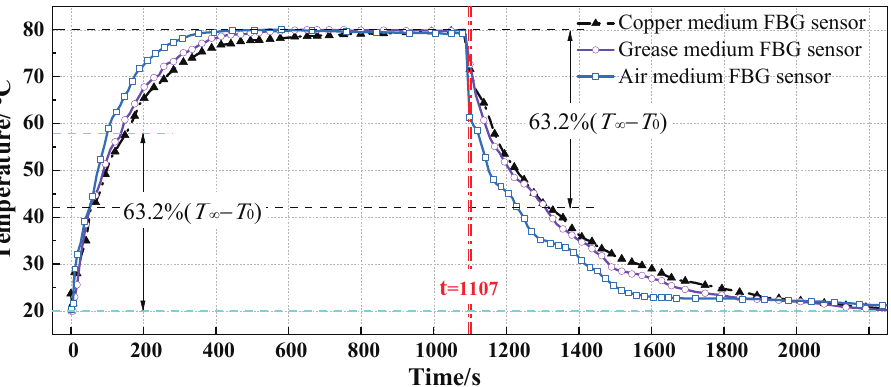
Figure 11. The temperature curve at the axis obtained by the experimental